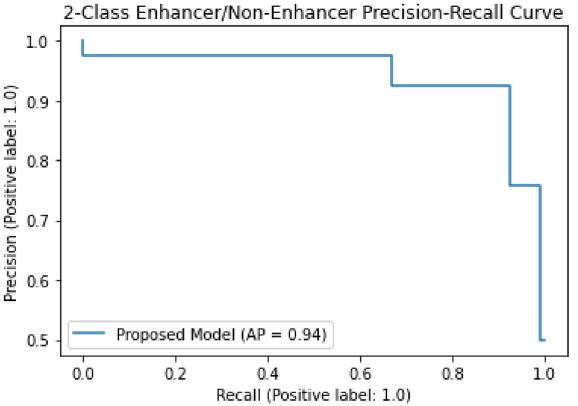
Figure 14. The PR curves of random forest using jackknife tests for enhancer site prediction.